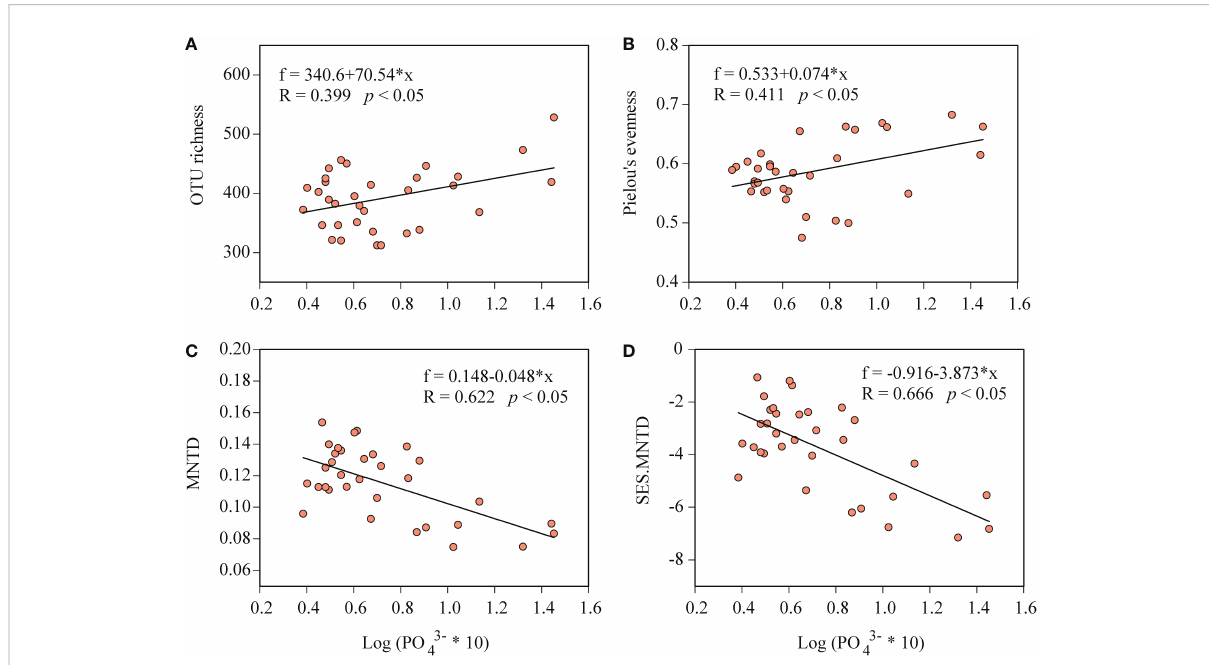
FIGURE 6 The distributions of the bacterial OTU richness (A) , Pielou ’ s evenness (B) , the mean nearest taxon distance (MNTD, C ) and the standardized- effect size of MNTD (SES.MNTD, D ) along the phosphate gradient in the Daya